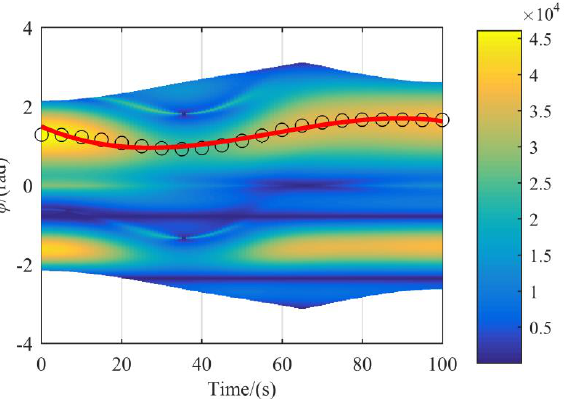
Figure 14. The relationship of φ and maneuverability index ω corresponding to the trajectory.